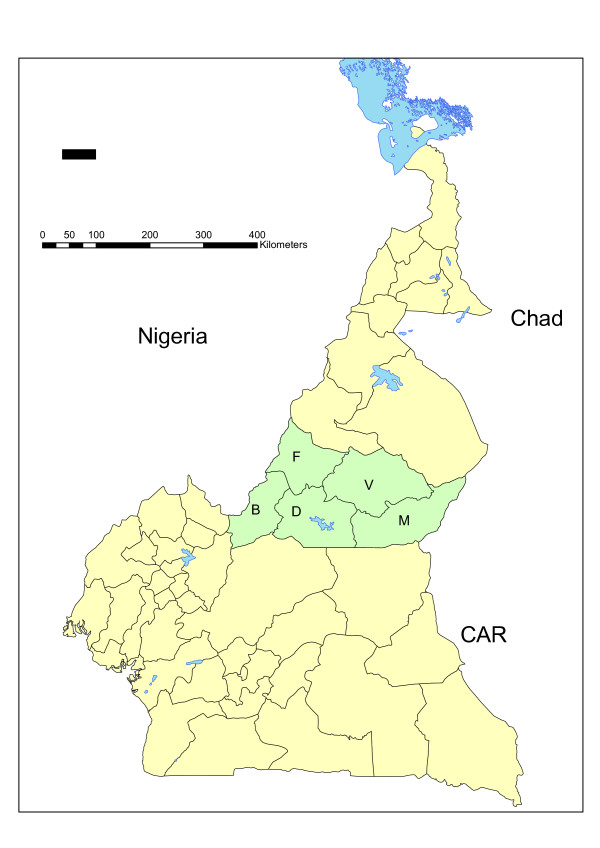
Map of Cameroon showing the Adamawa Province and the five Divisions, Vina (V), Mbere (M), Djerem (D), Mayo Bany0 (B) and Faro et Deo (F).